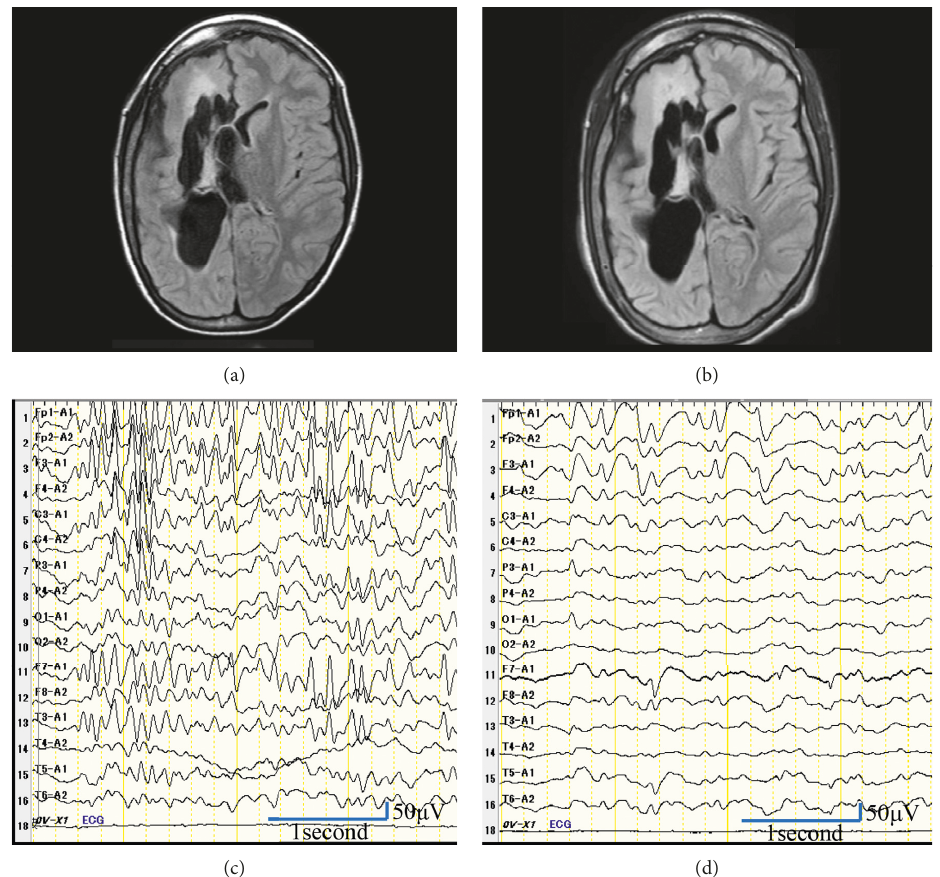
Figure 1: (a) MR image using fluid-attenuated inversion recovery (FLAIR) at 9 years 4 months. (b) Repeat FLAIR image obtained at 15 years 11 months (on day 7 after infection onset). (c) Electroencephalogram obtained during sleep at 15 years 1 month. (d) Electroencephalogram obtained during the period of impaired consciousness at 15 years 11 months. MR, magnetic